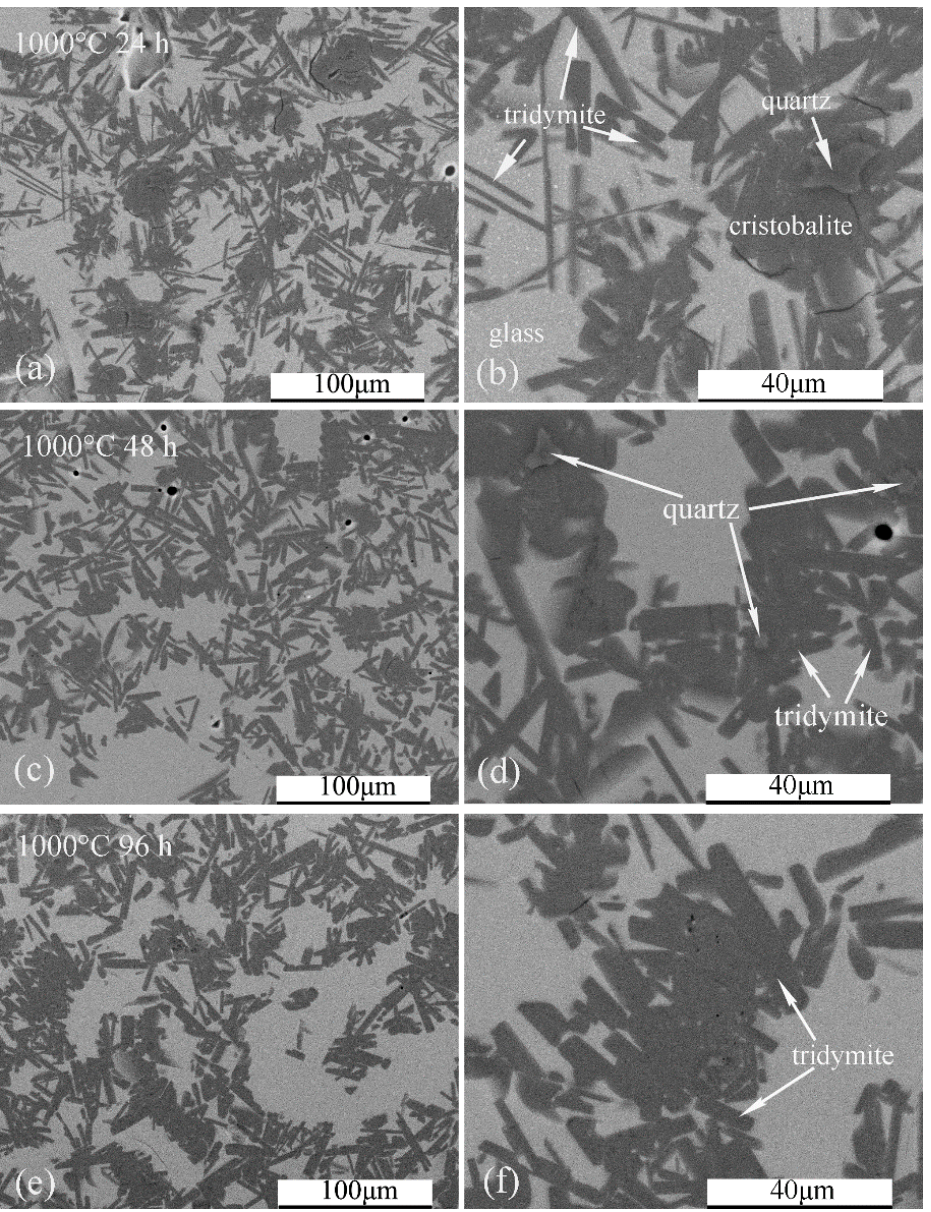
Figure 6. Microstructure of the coarse quartz—potassium silicate glass composites after holding at 1000 °C for different time: 24 h ( a , b ), 48 h ( c , d ) and 96 h ( e , f ).